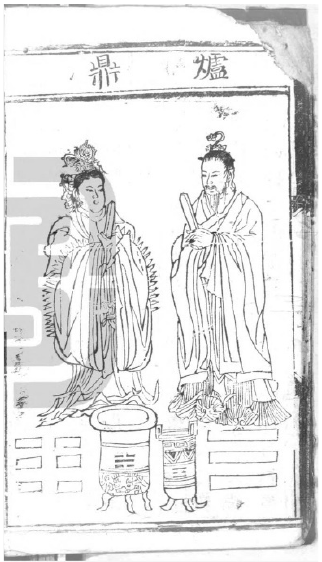
Figure 10. The diagram of the tripods found in Yiyuzi poetic version.